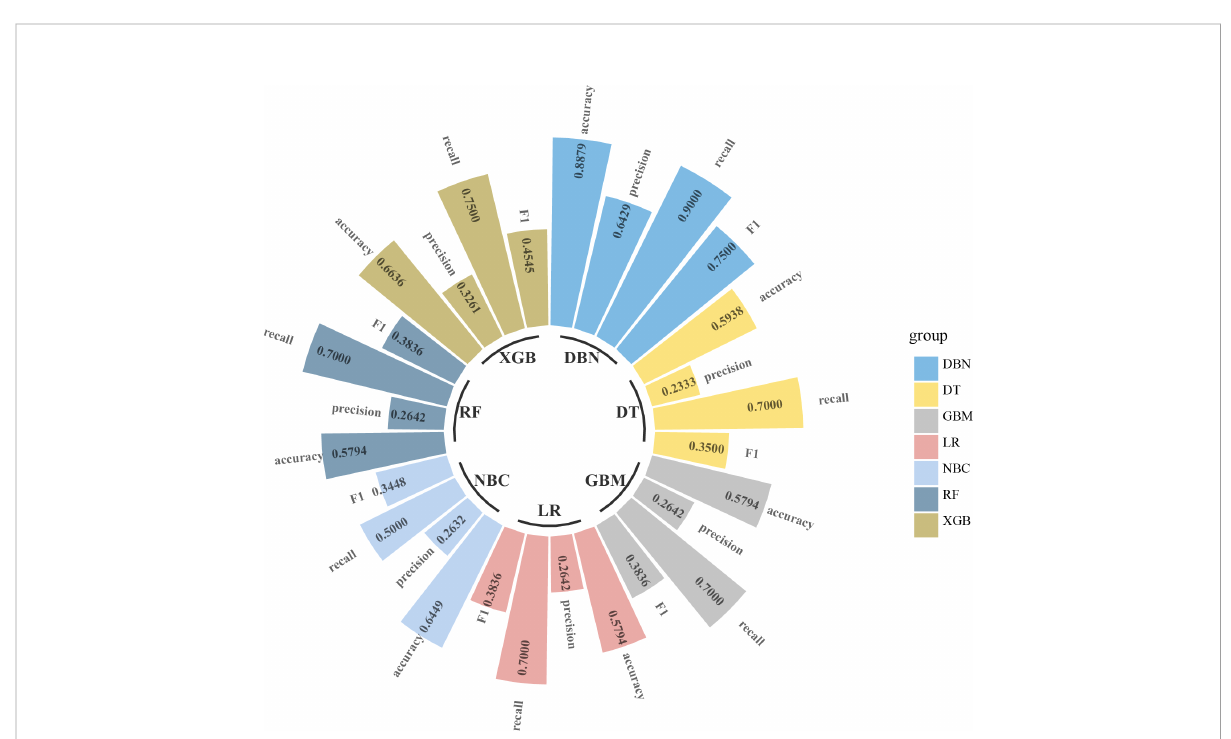
FIGURE 3 Circular bar plot. The performance of six models has been evaluated by fi ve criteria of AUC, accuracy, precision, recall, and F1. AUC, area under the receiver operating characteristic